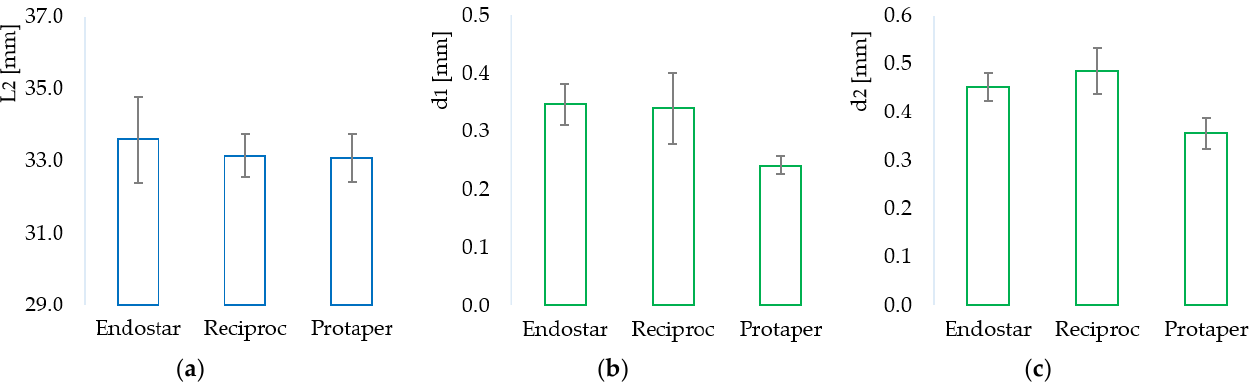
Figure 4. The measured dimensions of the instruments of each study group after fracture: ( a ) length L 2 (mm); ( b ) minimum d 1 (mm) and ( c ) maximum d 2 (mm) dimension of the fracture section.